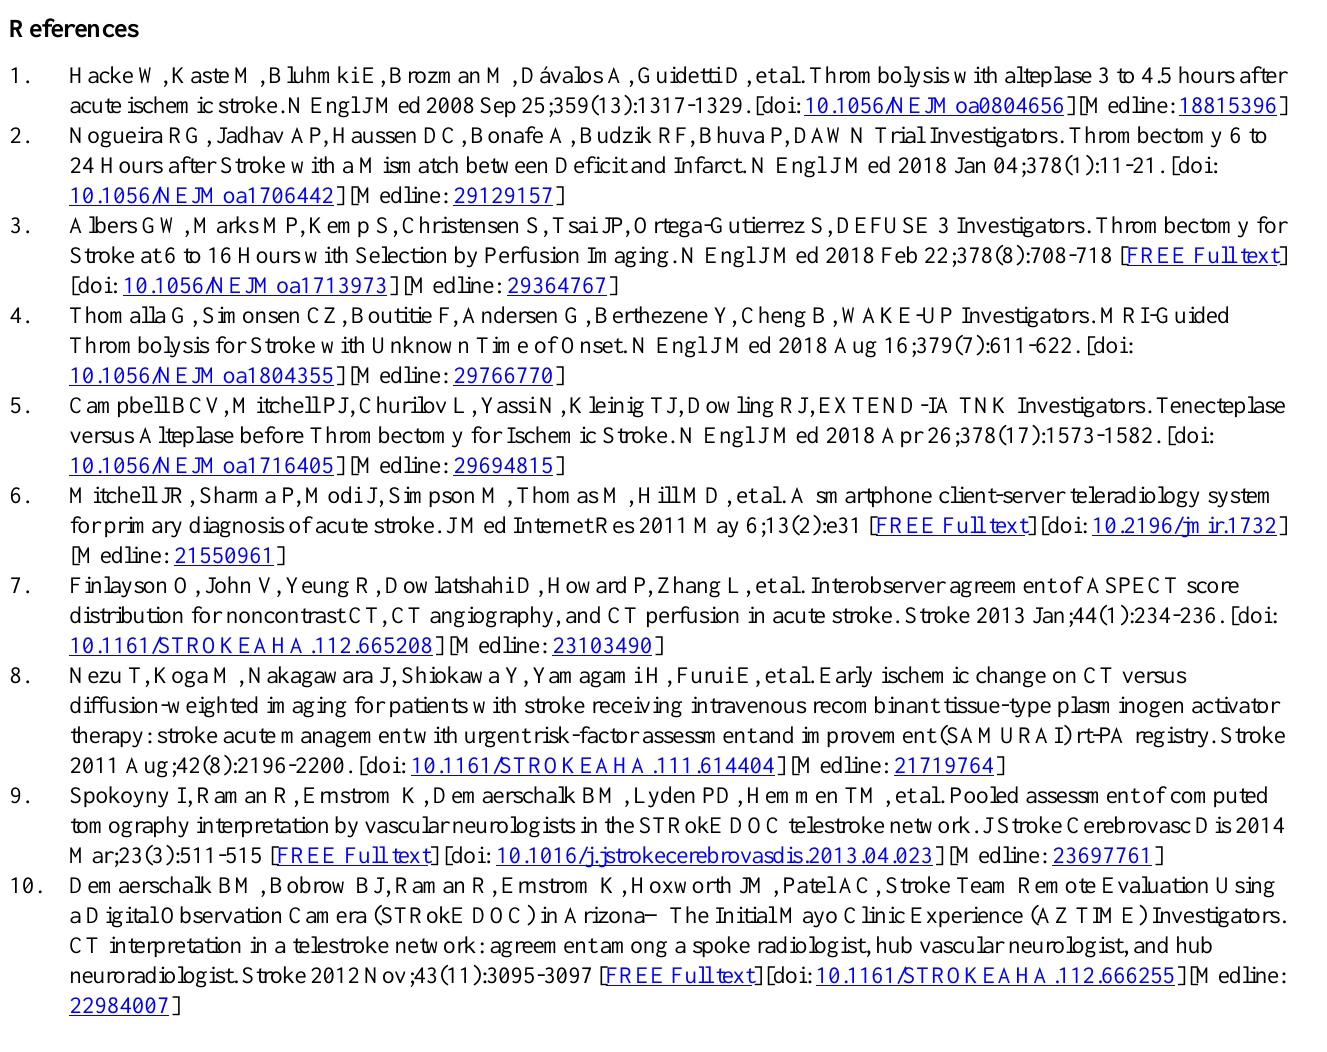
Table S4. Inter-rater agreement for DWI-ASPECTS ≥ 7 or DWI-ASPECTS <7 for smartphone monitor in VN1 vs desktop PC monitor in